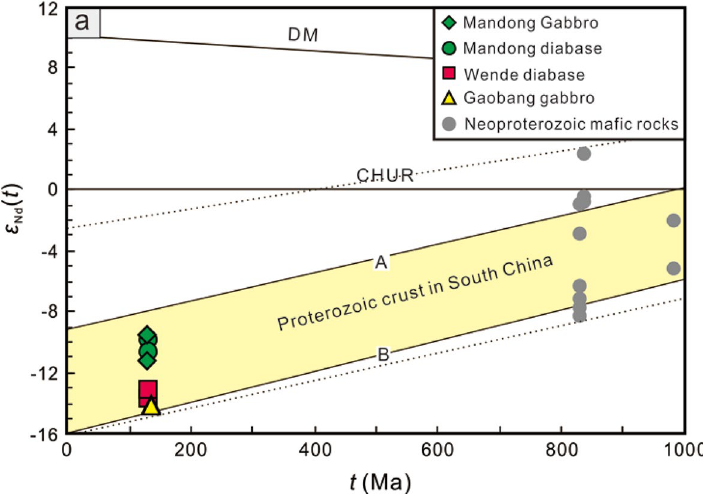
Figure 5. Plots of ε Nd ( t ) versus t for the studied mafic rocks in the Baotan